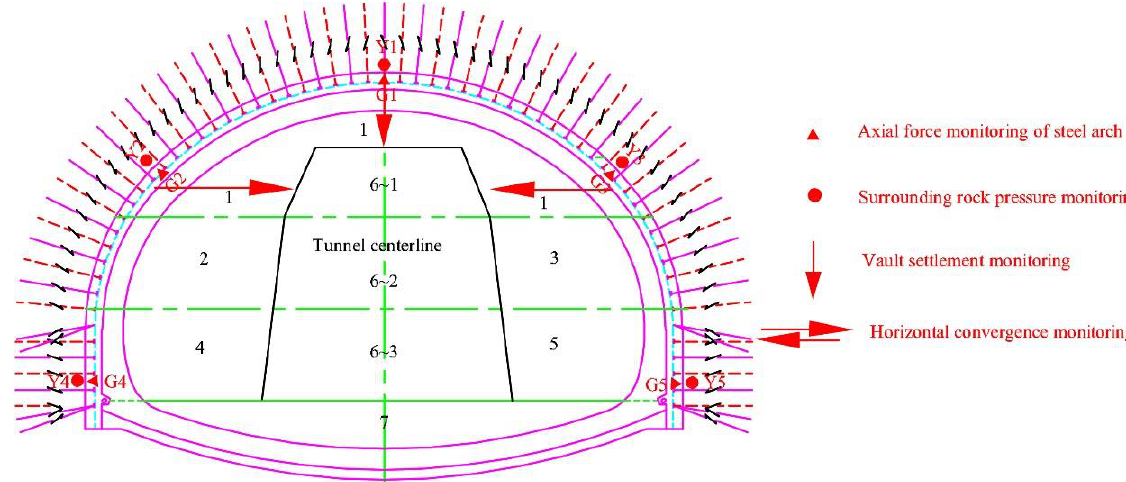
Figure 8. Layout of the monitoring points.